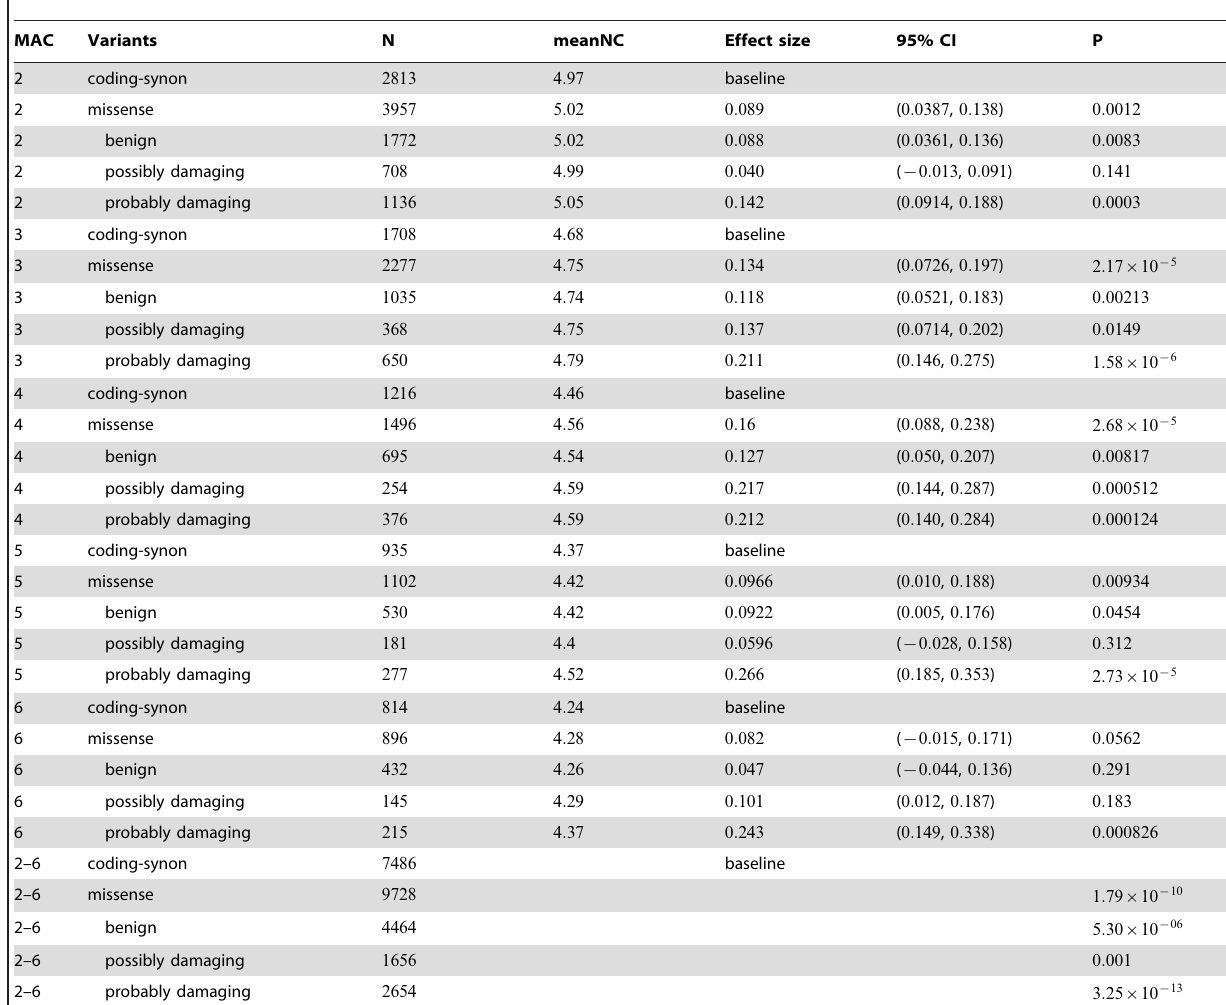
Table 1. Discrimination of derived missense alleles by the NC